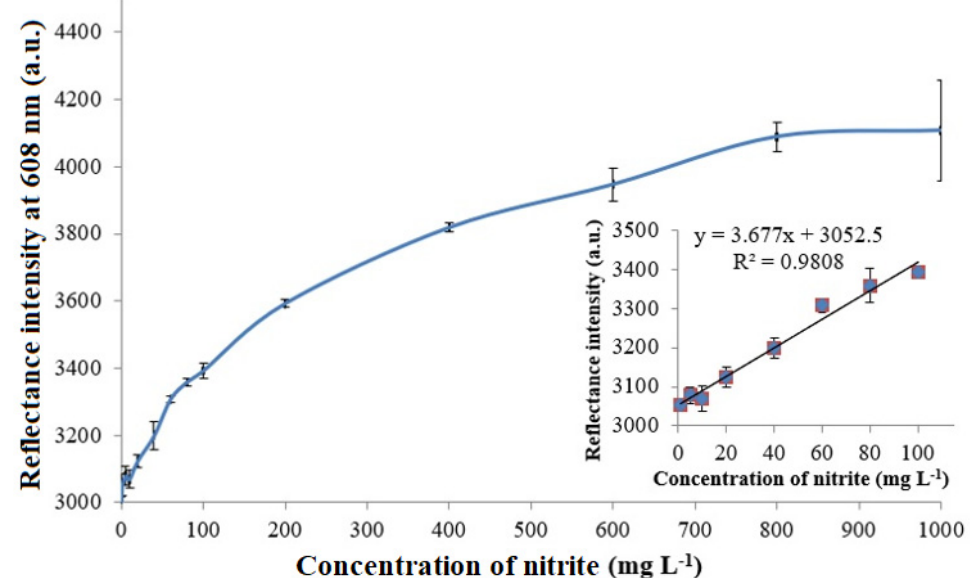
Figure 5. The nitrite concentration-dependent reflectometric microbial biosensor response at the nitrite concentration range of 1-1000 mg L − 1 in 0.1 M K-phosphate buffer at a neutral pH. The inset shows the dynamic linear response range of the reflectance nitrite biosensor from 1-100 mg L − 1 nitrite.